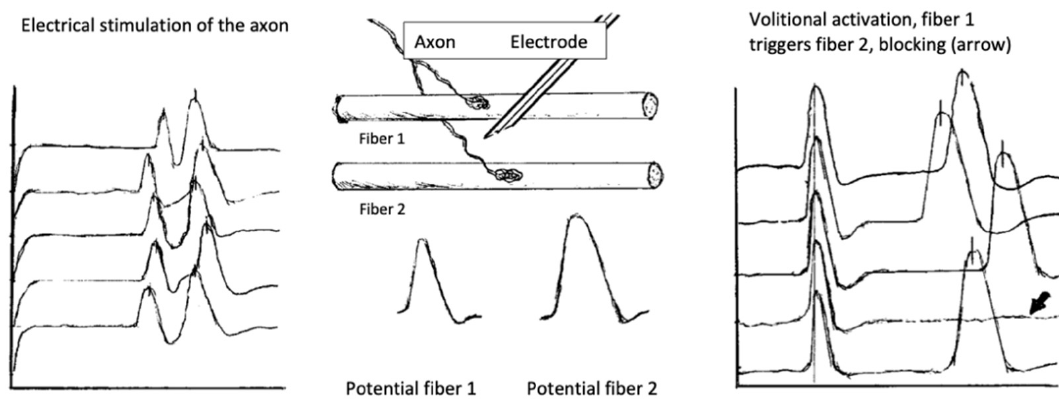
Figure 6. The electrode in position to pick up potentials from Fiber 1 and Fiber 2 at the same time. Electrical stimulation excites both fibers. Some technical aspects (subliminal stimulation, intrusion of “new” fibers with minimal increase in stimulation) make the study less easy than it seems. Volitional jitter is free of false-positives but may be more tricky for the operator and longer, less tolerable, for the patient.